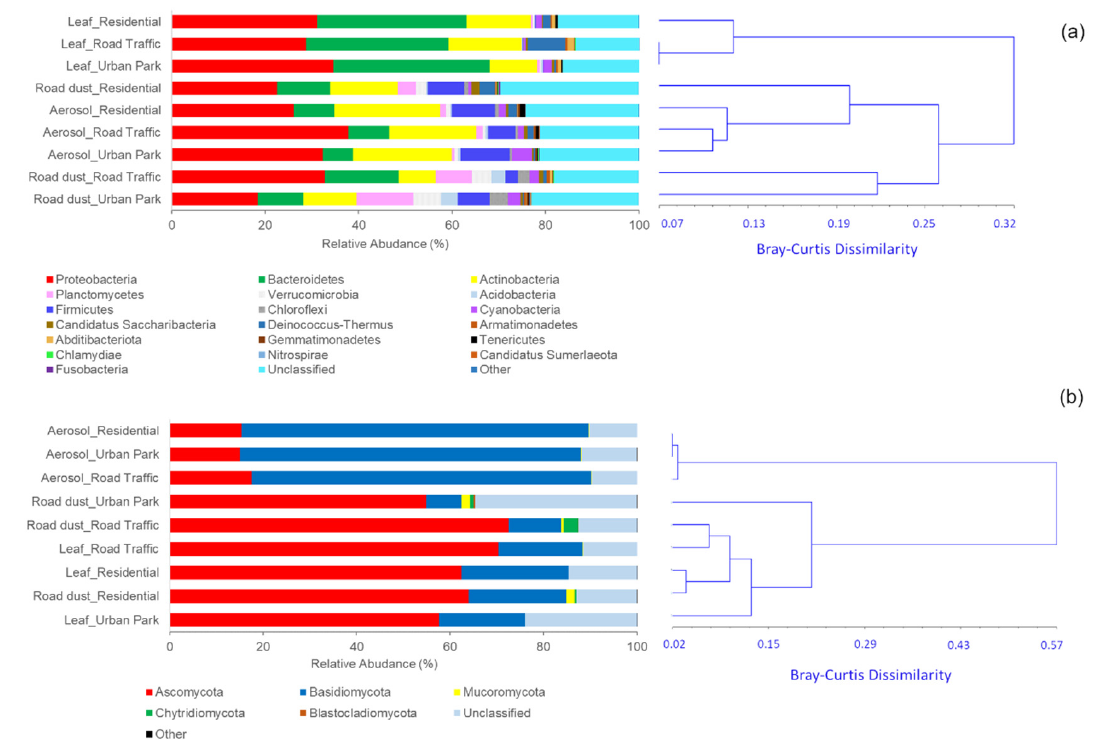
Figure 3. Distribution of the most abundant bacterial ( a ) and fungal ( b ) phyla (read frequency > 0.01%) identified in the airborne (Aerosol), paved road surfaces (Road dust) and leaf surfaces of Q. ilex trees (Leaf) in three urban sites of Rome: Urban Park, residential area (Residential) and polluted area close to the traffic roads (Road Traffic). Unclassified phyla and phyla with relative abundance ≤ 0.01% were considered as “Unclassified” and “Other”, respectively. Clustering analysis of the phy- lum-level communities based on the computation of the pairwise Bray-Curtis dissimilarity matrix is also